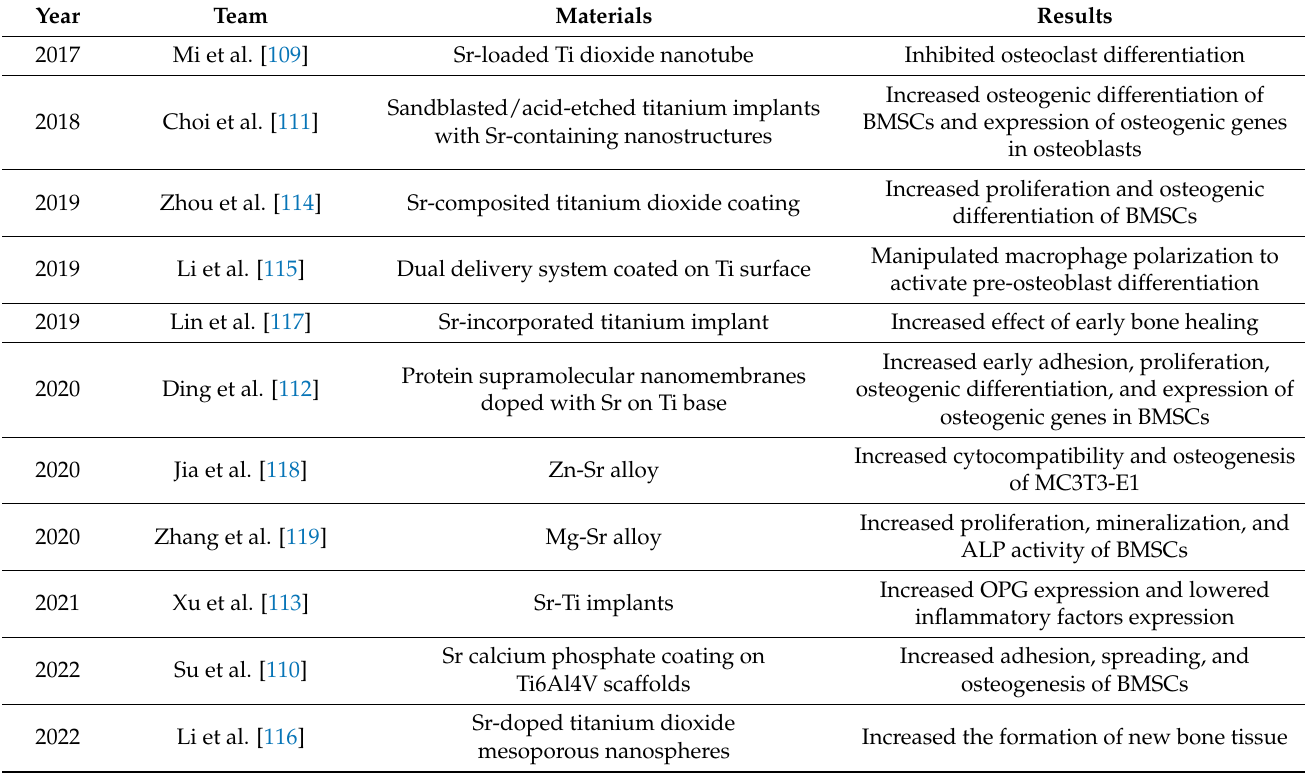
Table 6. The application of Sr compound with metal-based